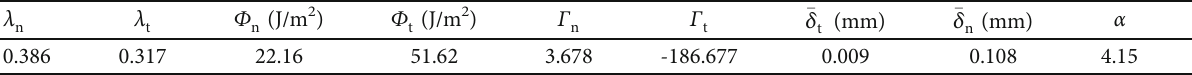
Table 1: Fracture criteria of the PPR CZMs for the coal.